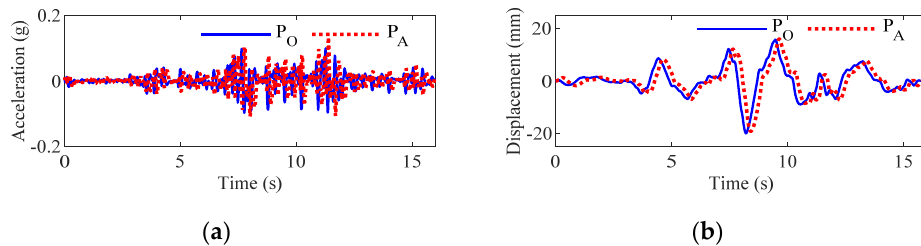
Figure 23. Accelerations and displacements in sample 2: ( a ) simulated accelerations and ( b ) its corresponding displacements.